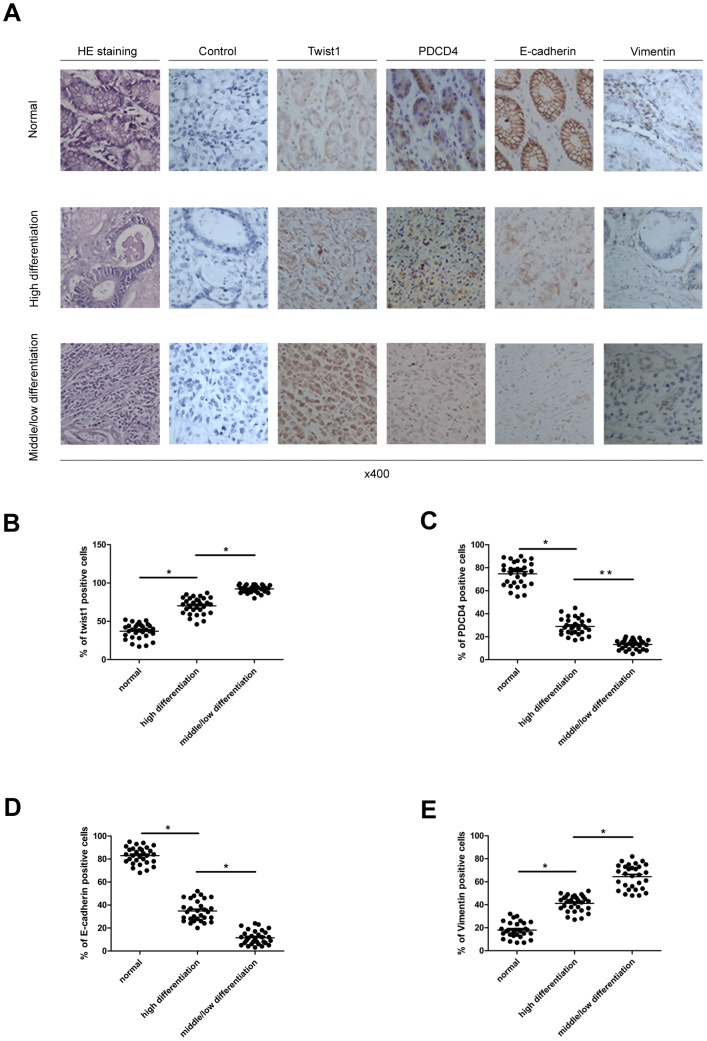
Expression of epithelial–mesenchymal transition (EMT)-related genes and programmed cell death factor 4 (PDCD4) were regulated in human gastric cancer tissues.(A) Hematoxylin and eosin staining confirmed preoperative diagnosis and histological grade. Representative immunohistochemical staining of TWIST1, SNAIL, PDCD4, vimentin and E-cadherin distinct in adjacent normal tissue and high differentiation cancer tissue and middle/low differentiation cancer tissue. (B–E) Quantification of TWIST1-, SNAIL-, PDCD4-, vimentin- and E-cadherin- expression in normal and cancer tissues. The total number of samples is 30 and each point represents 1 sample. Horizontal medium bar is mean and whiskers are SD. *
P<0.05 and **
P<0.01 versus control.